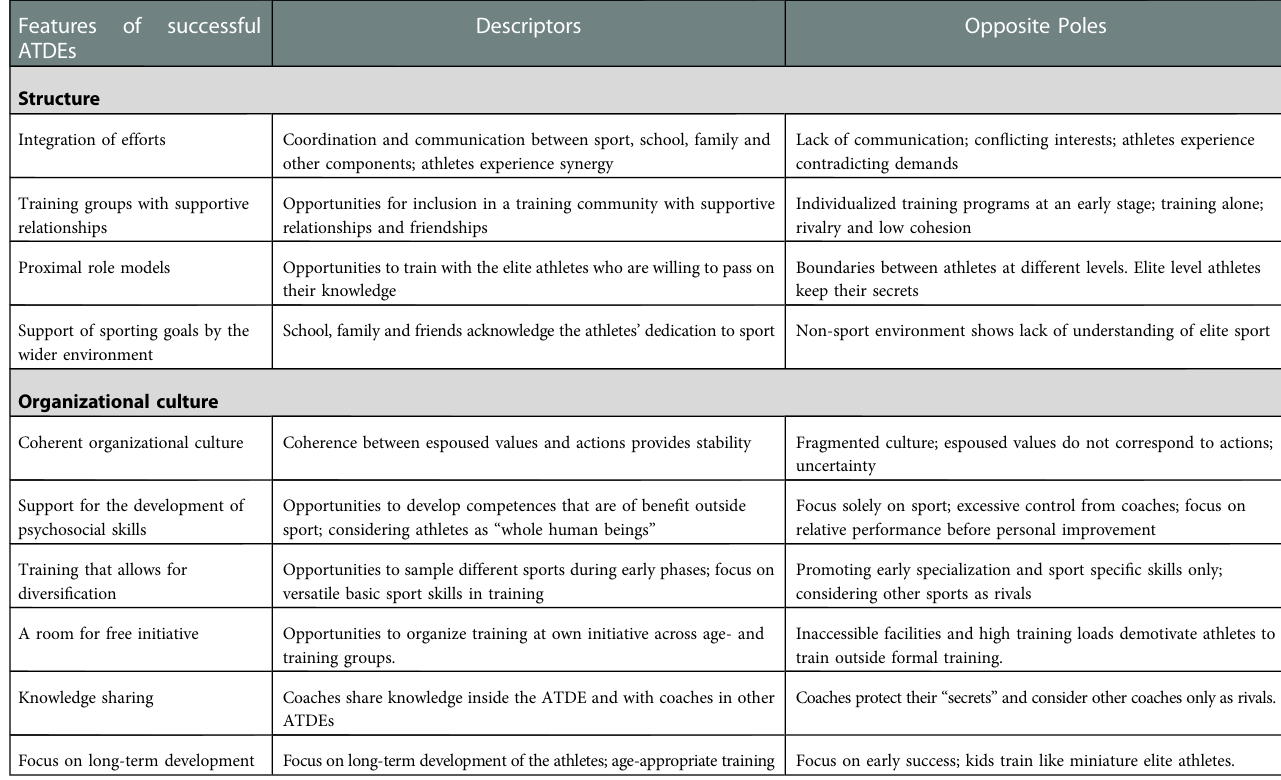
TABLE 1 Shared features of successful ATDE s.